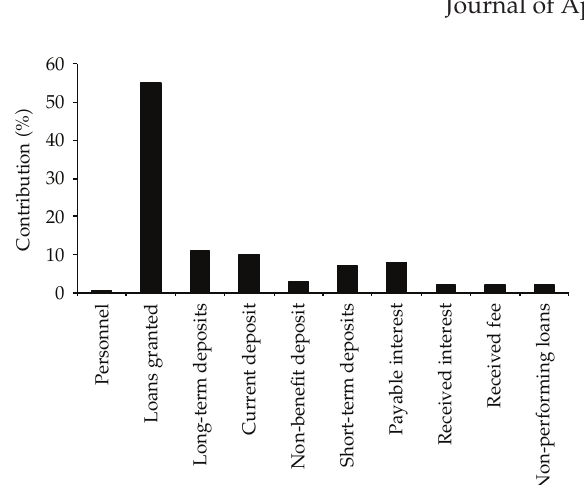
Figure 1: The relative contributions of di ff erent variables on the overlap in DEA-DA in example 1 that the real data set consists of 78 banking